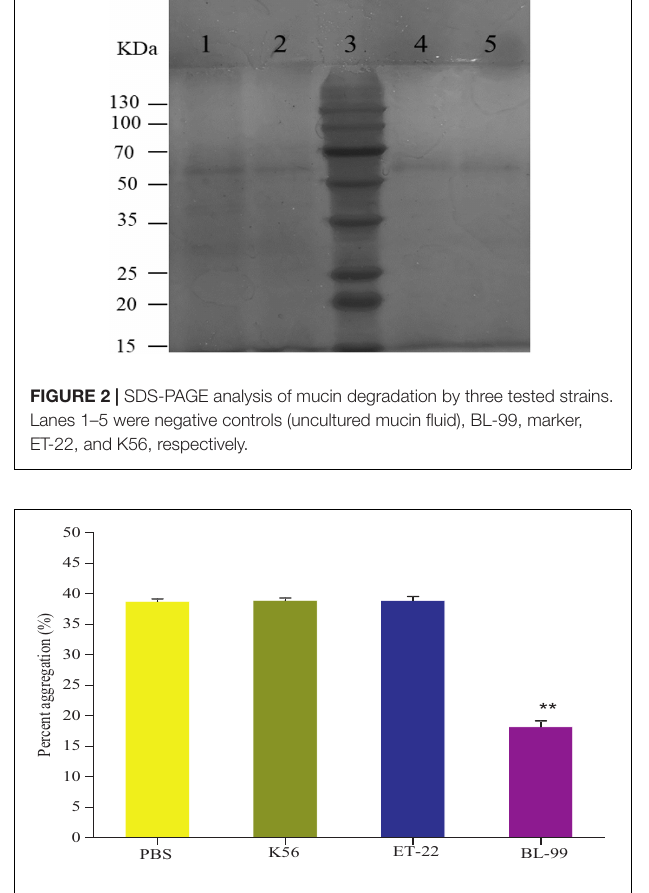
FIGURE 3 | Detection of platelet aggregation ability in rabbit blood by tested bacterial strain samples. PBS was set as control group. Additionally, K56, ET-22, and BL-99 were marked as strains of L. paracasei K56 and ET-22 and Bifidobacterium lactobacillus BL-99, respectively. ** p <